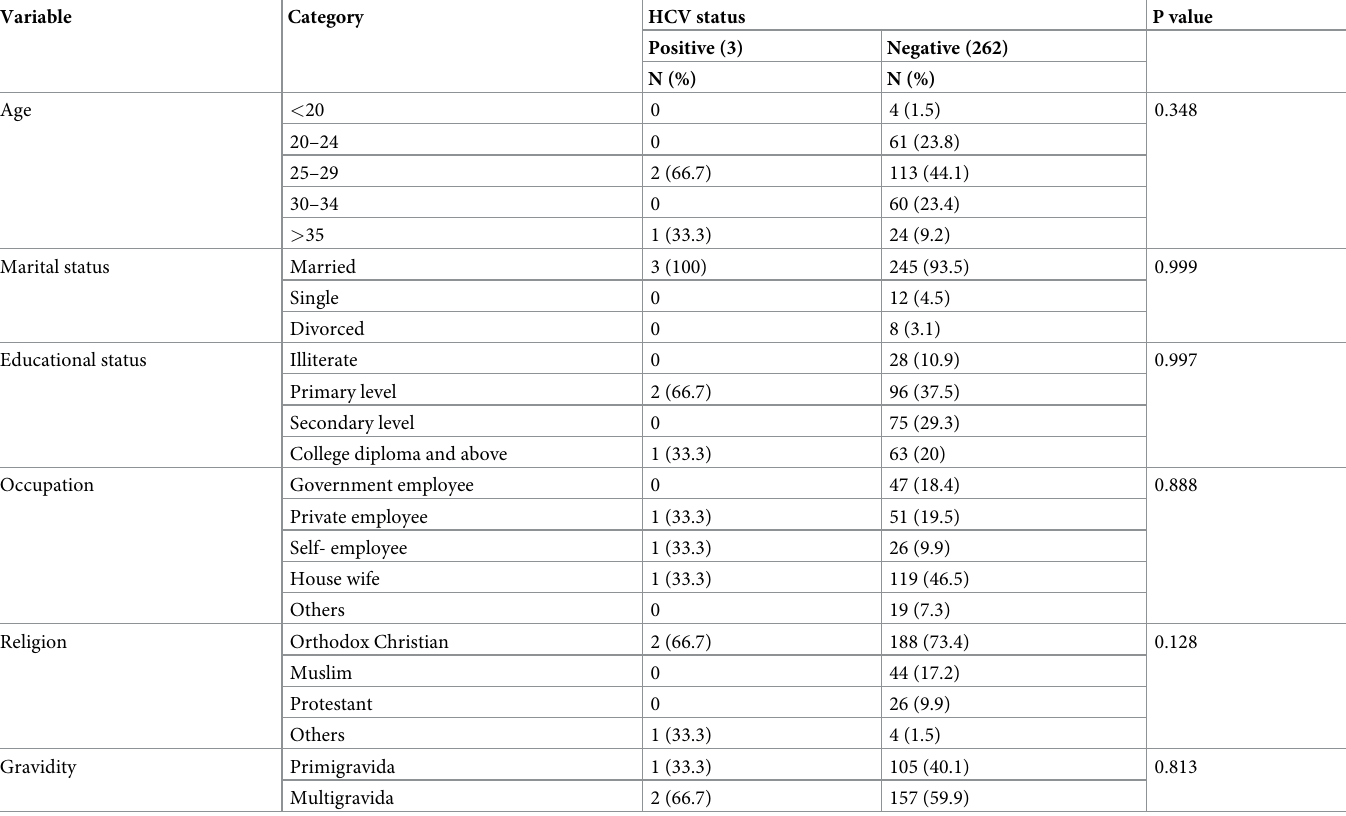
Table 4. Socio-demographic characteristics and HCV co-infection among HBsAg positive delivering mothers in governmental hospitals in Addis Ababa, 2019–